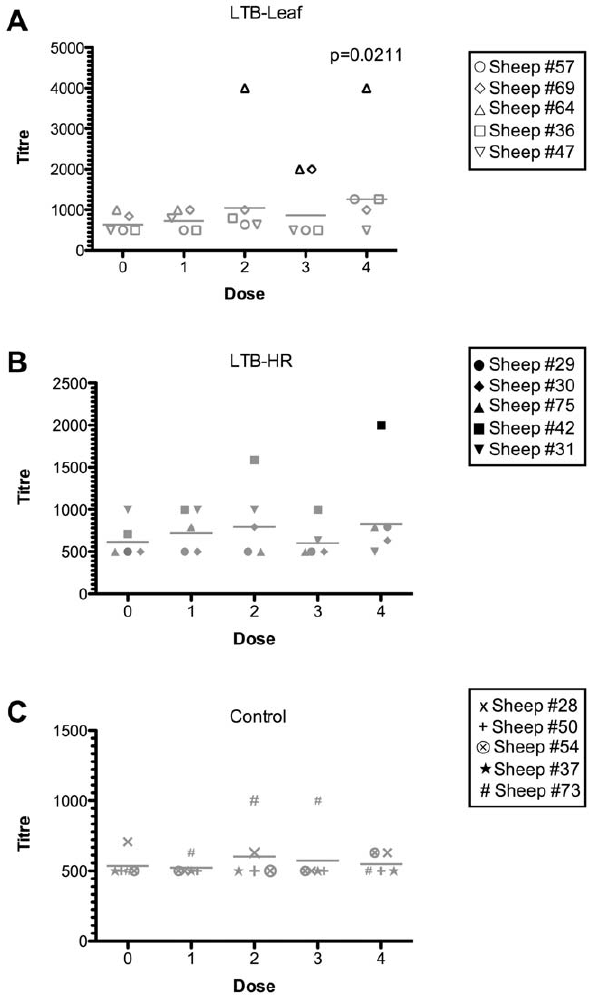
Figure 1. LTB-specific IgG antibody titres in serum collected from sheep before immunisation with LTB-Leaf (A), LTB-HR (B) or control vaccines (C). Black symbols denote positive responders defined as sheep with antibody titres at least three standard deviations above the control mean, non-responders are indicated by grey symbols. The horizontal lines represent geometric means, statistical analysis (Student’s t-test determined a significant difference between the means of the control and LTB-Leaf groups after four doses, p , 0.05).